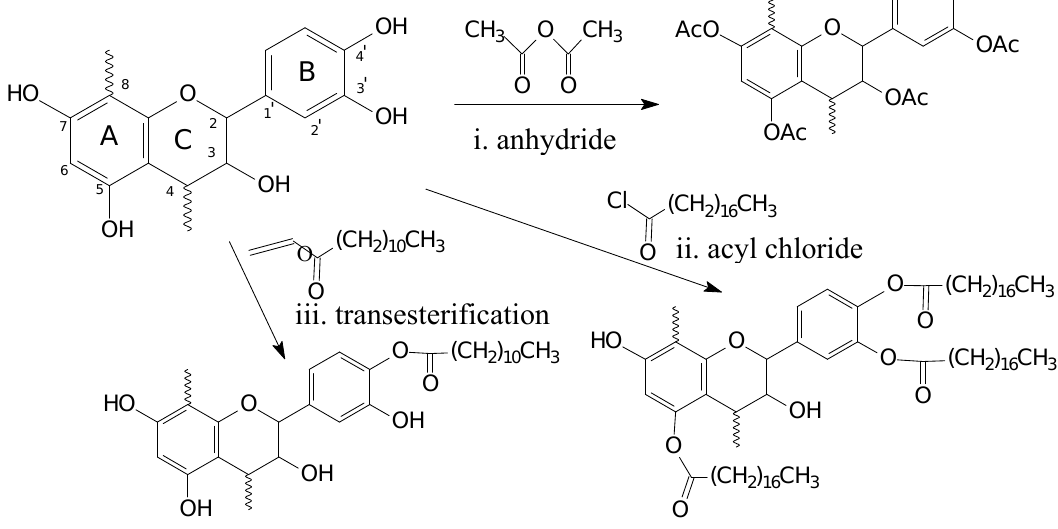
Figure 1. Reaction scheme showing the procyanidin structure repeat unit common in condensed tannins [12] and various routes to tannin ester formation including ( i ) acid anhydride with acetic anhydride [18]; ( ii ) acyl chloride with stearoyl chloride [19]; and ( iii ) transesterification with vinyl laurate